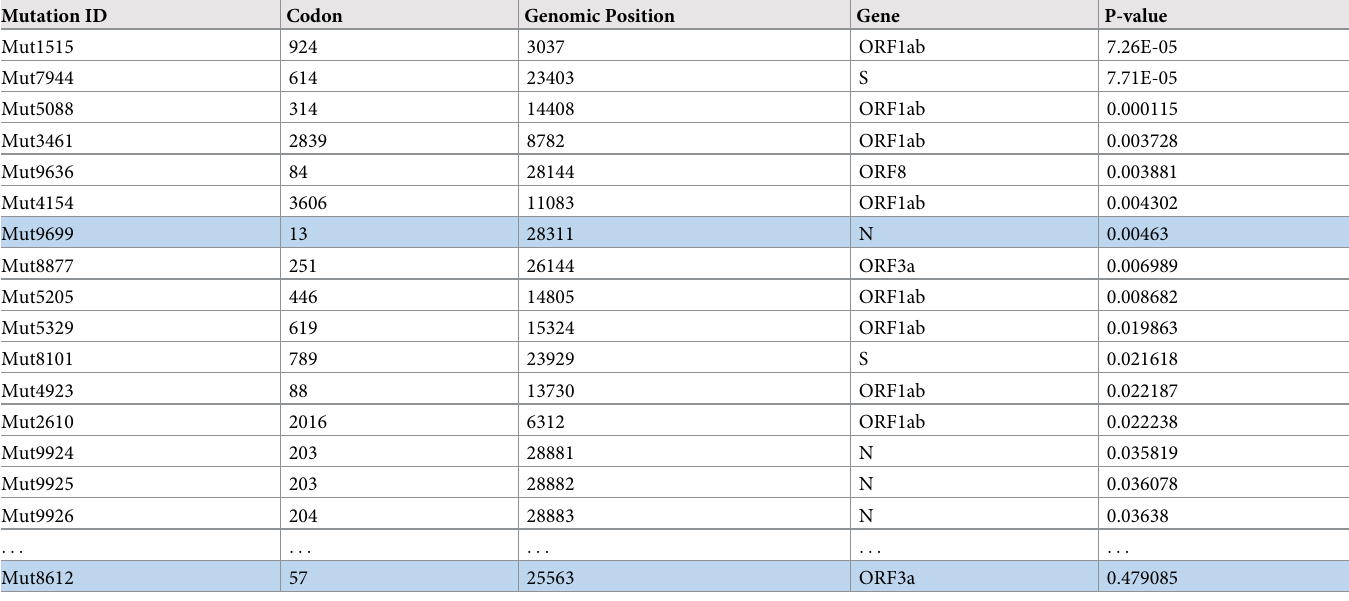
Two selected protein mutation of interest highlighted in light blue (see sections below for